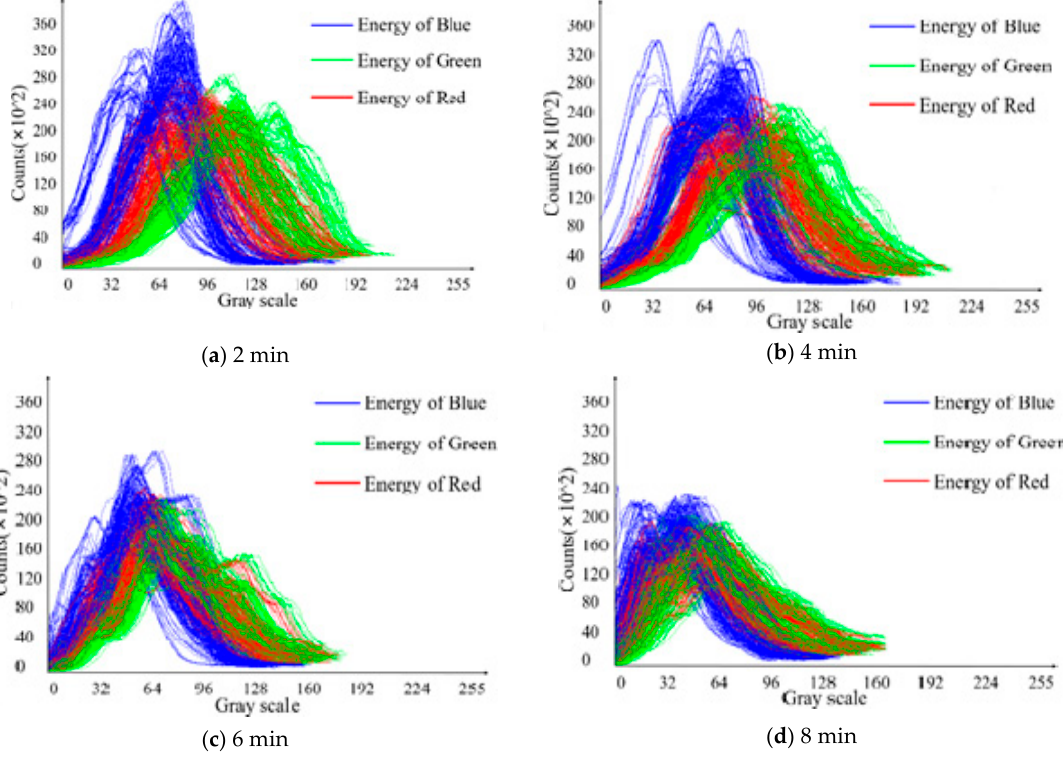
Figure 11. Energy distribution curve of adaptive filtering corresponding to images at different fixation time.